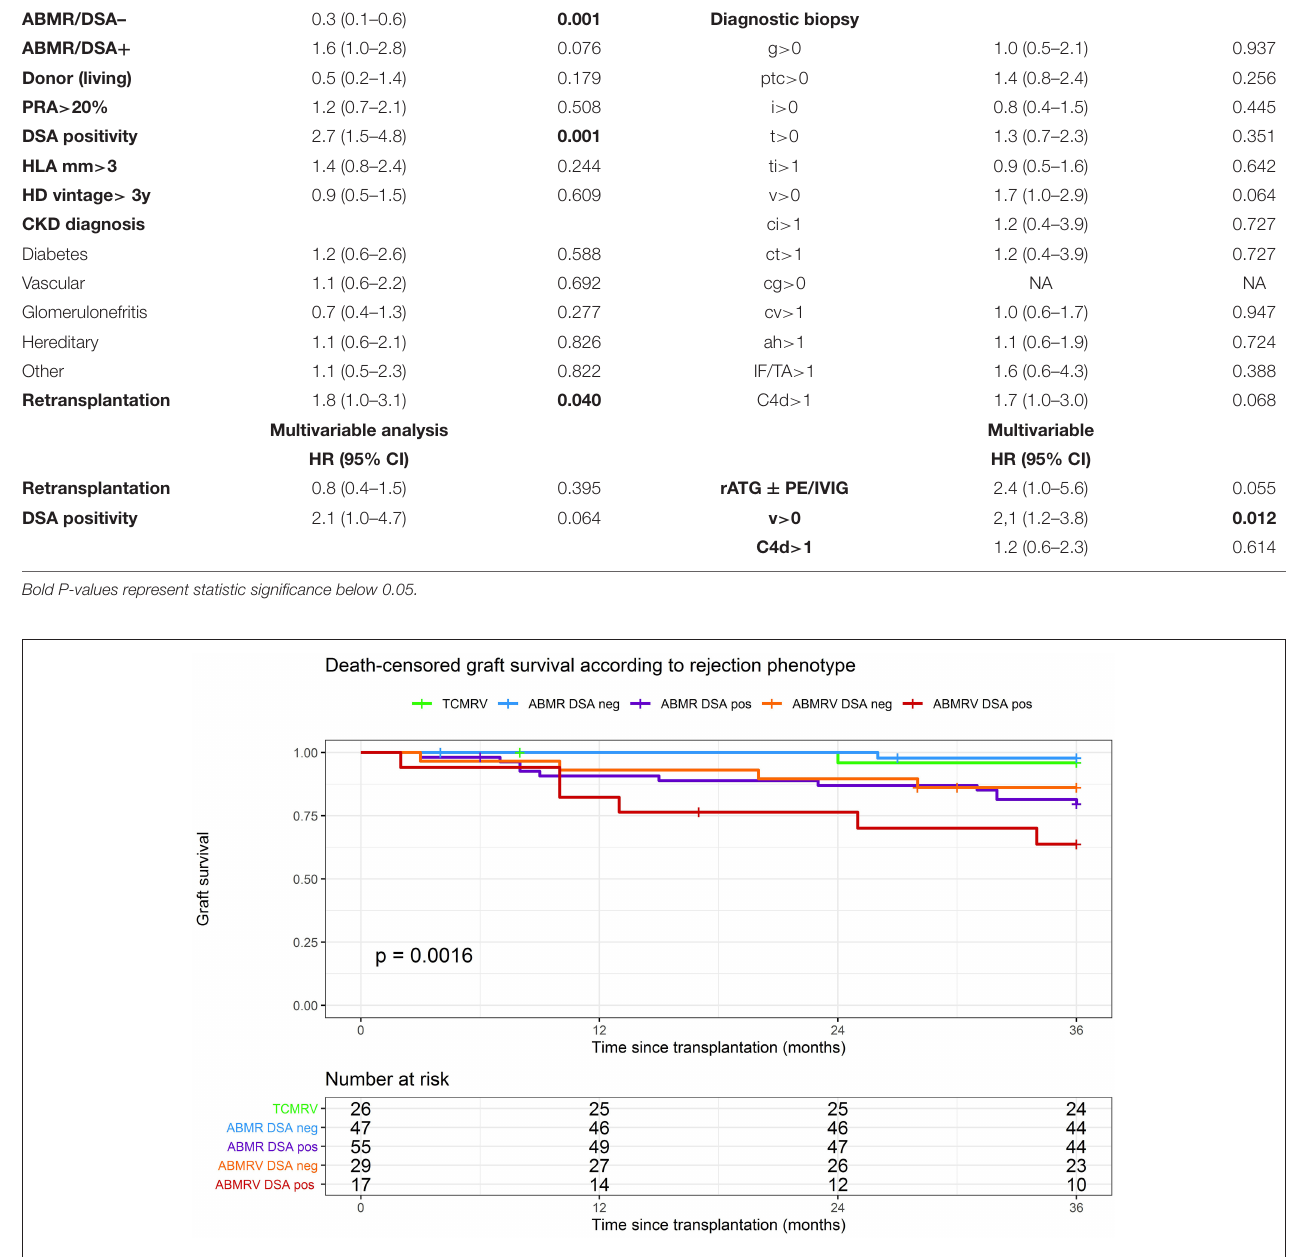
FIGURE 4 | Death-censored graft survival according to rejection phenotype.